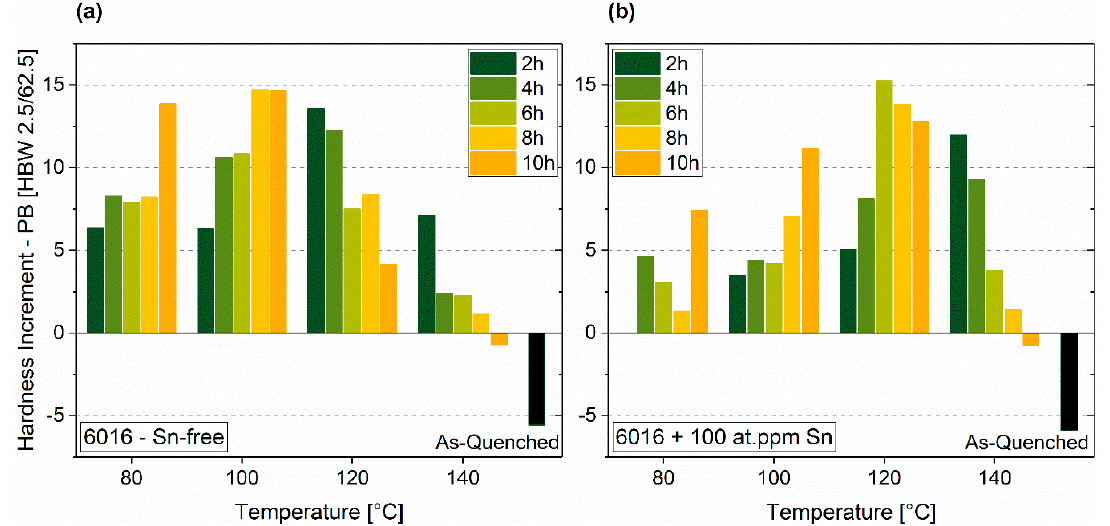
Figure 5. Paint-Bake response (185 °C, 20 min, no pre-deformation) of samples treated according to PA1 for EN-AW-6016 Sn-free ( a ) and EN-AW-6016 + 100 at.-ppm Sn ( b ).